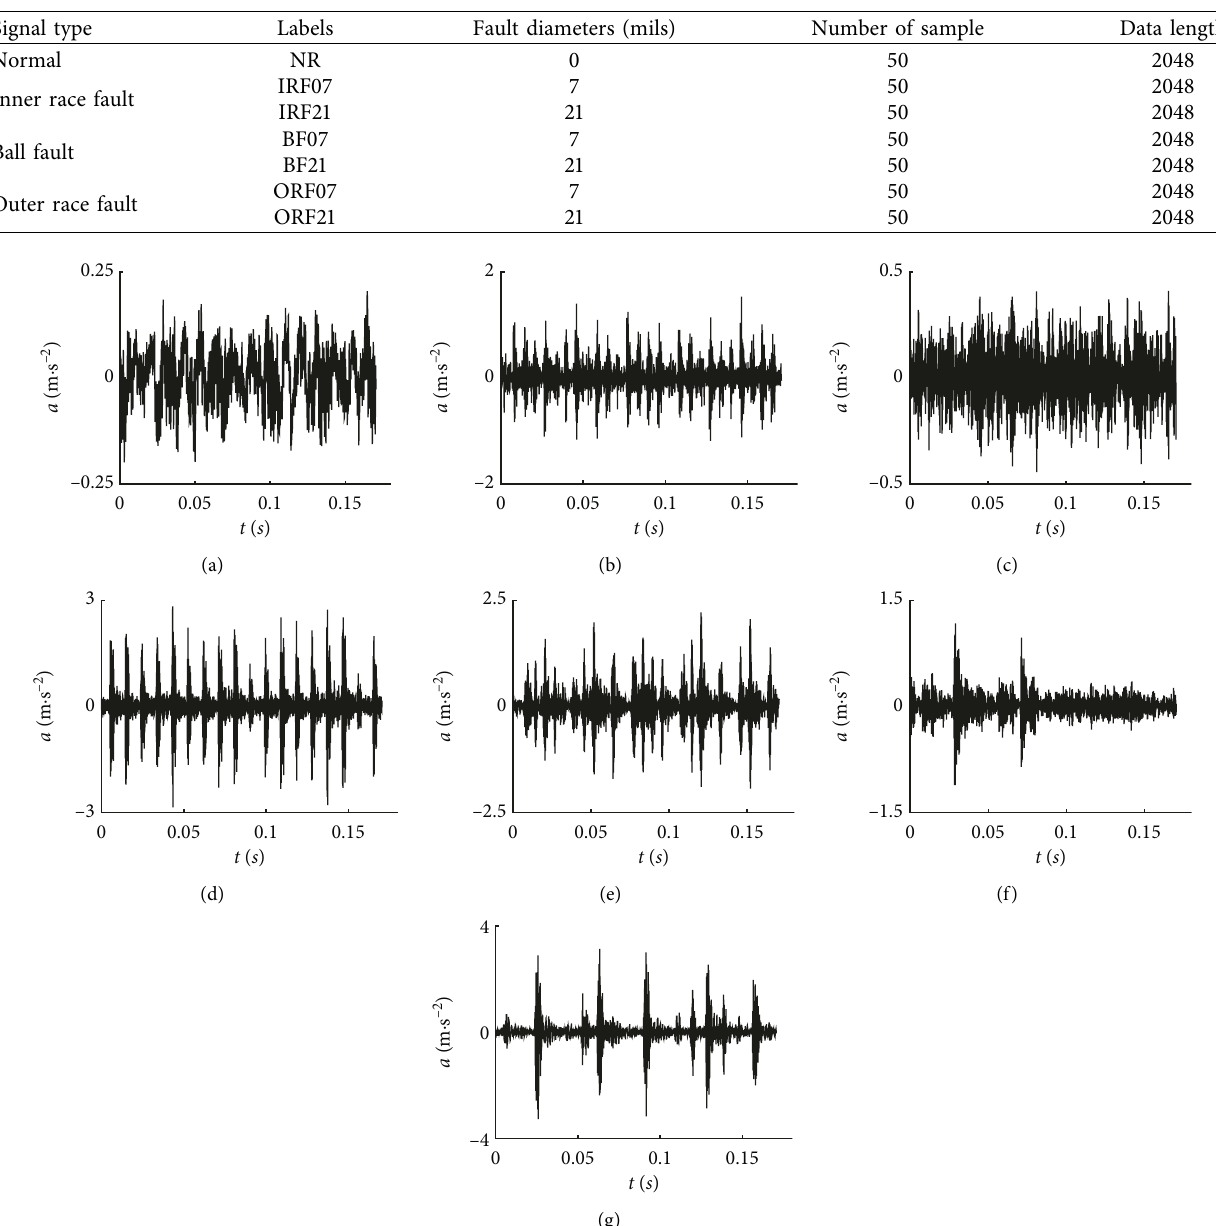
Table 2: The details of the datasets for rolling bearing experiment.